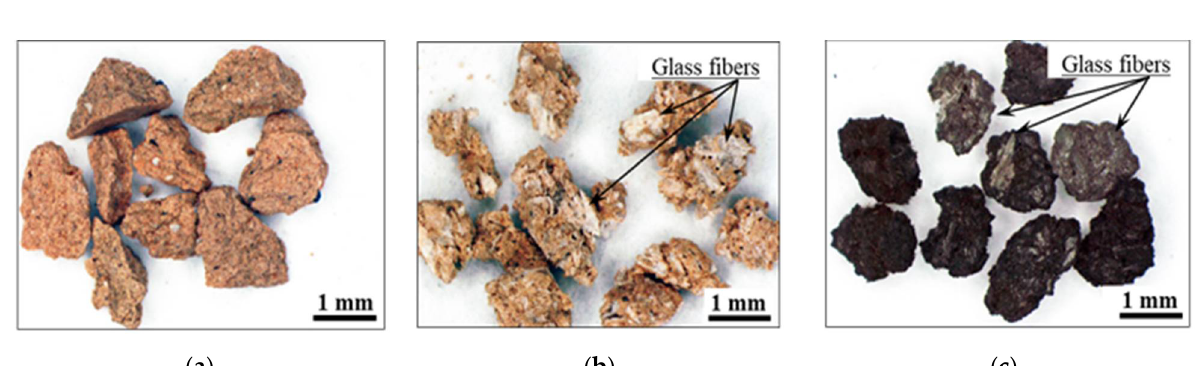
Table 1. Compositions of inorganic substances in the clay and GFRP.